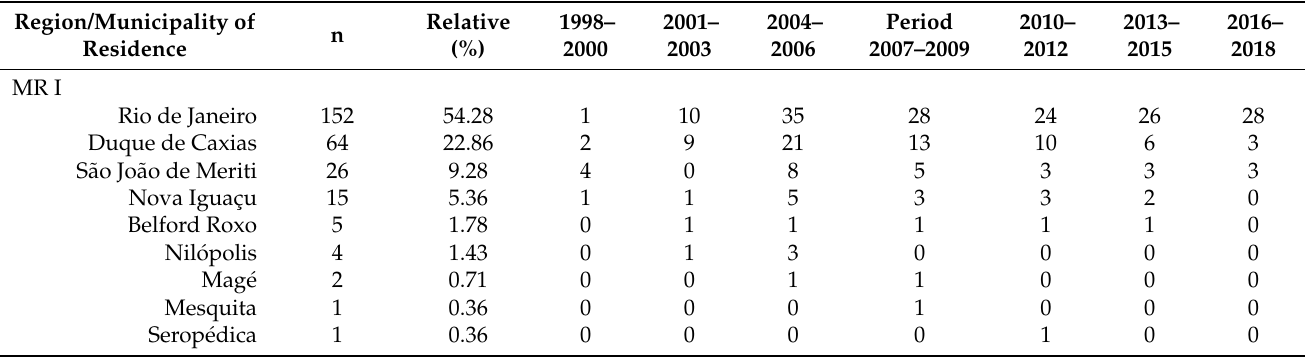
Table 1. Distribution of canine sporotrichosis cases by municipality of residence in the state of Rio de Janeiro, Brazil, 1998–2018.